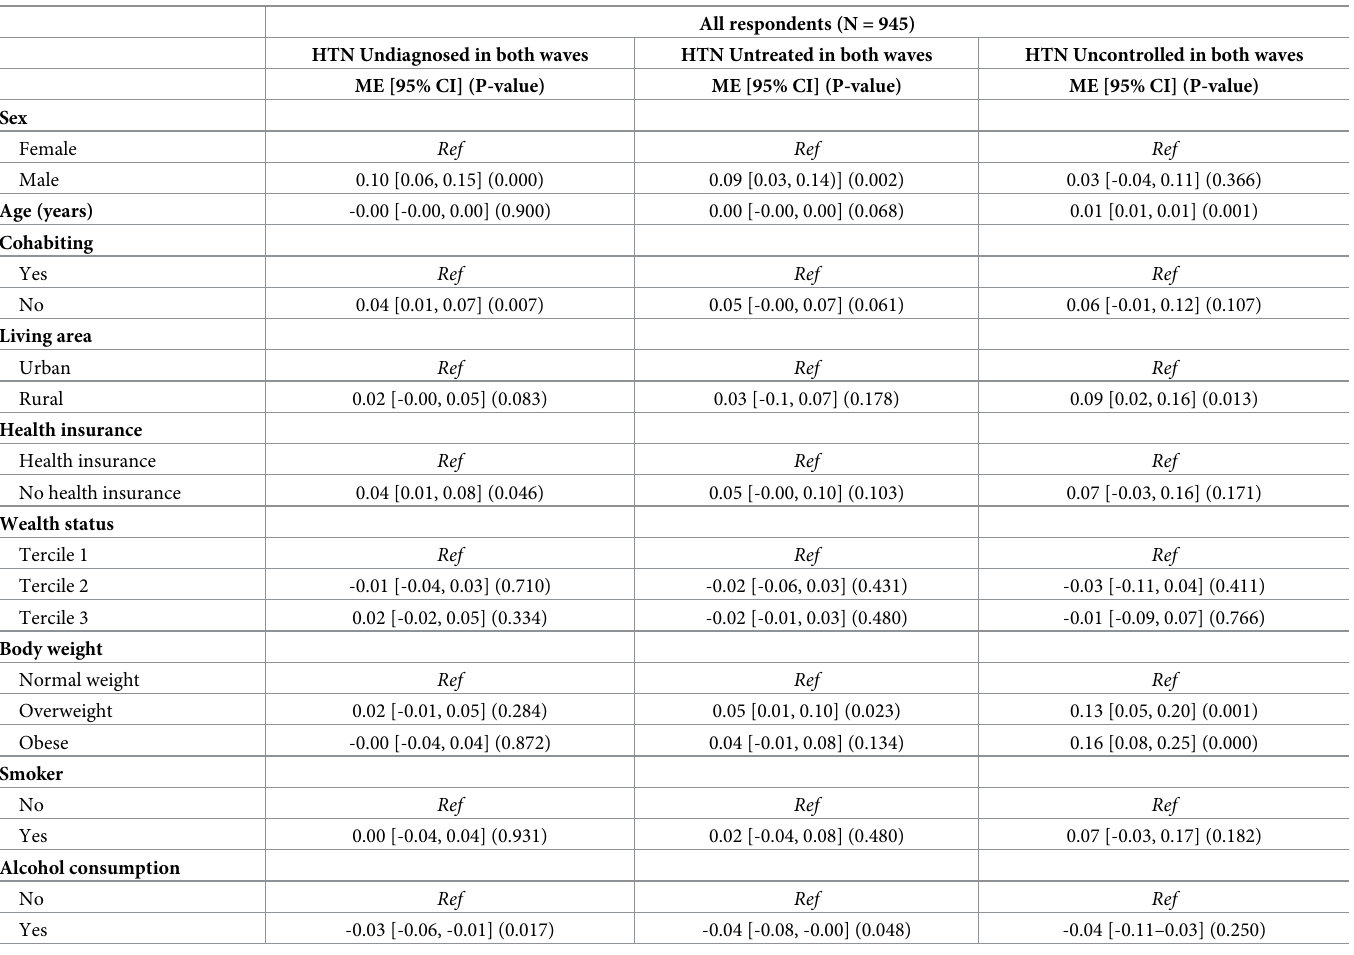
Table 6. Averaged marginal effects on probabilities of persistent undiagnosed, untreated, and uncontrolled